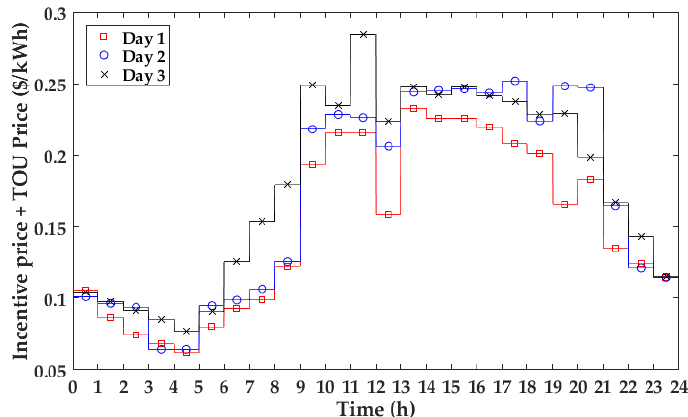
Figure 10. Sums of incentive prices and TOU prices.